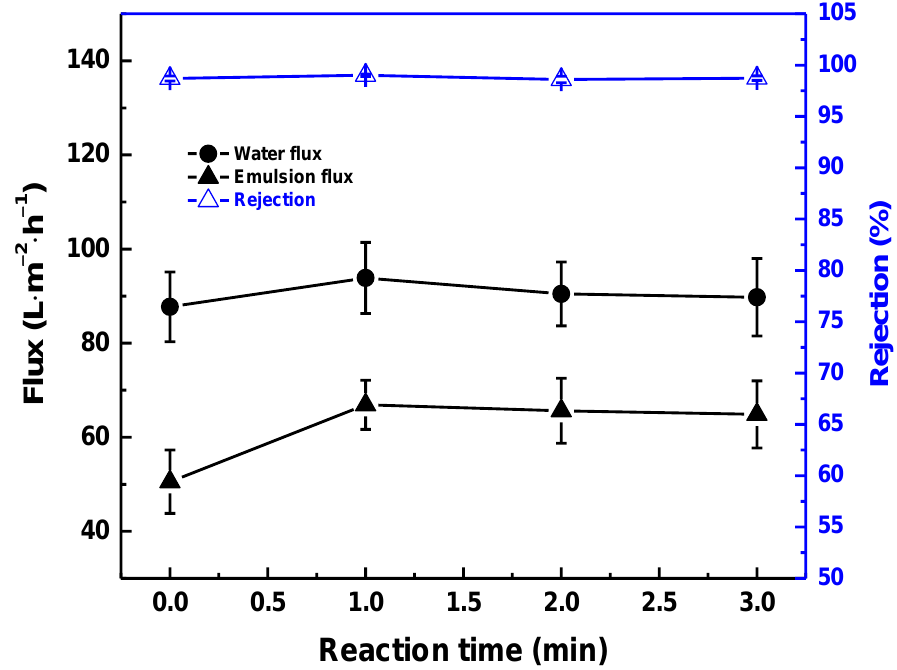
Figure 4. Effect of reaction time between TA and FeIII. Feed: H 2 O/diesel (99/1) emulsion at 1 bar.